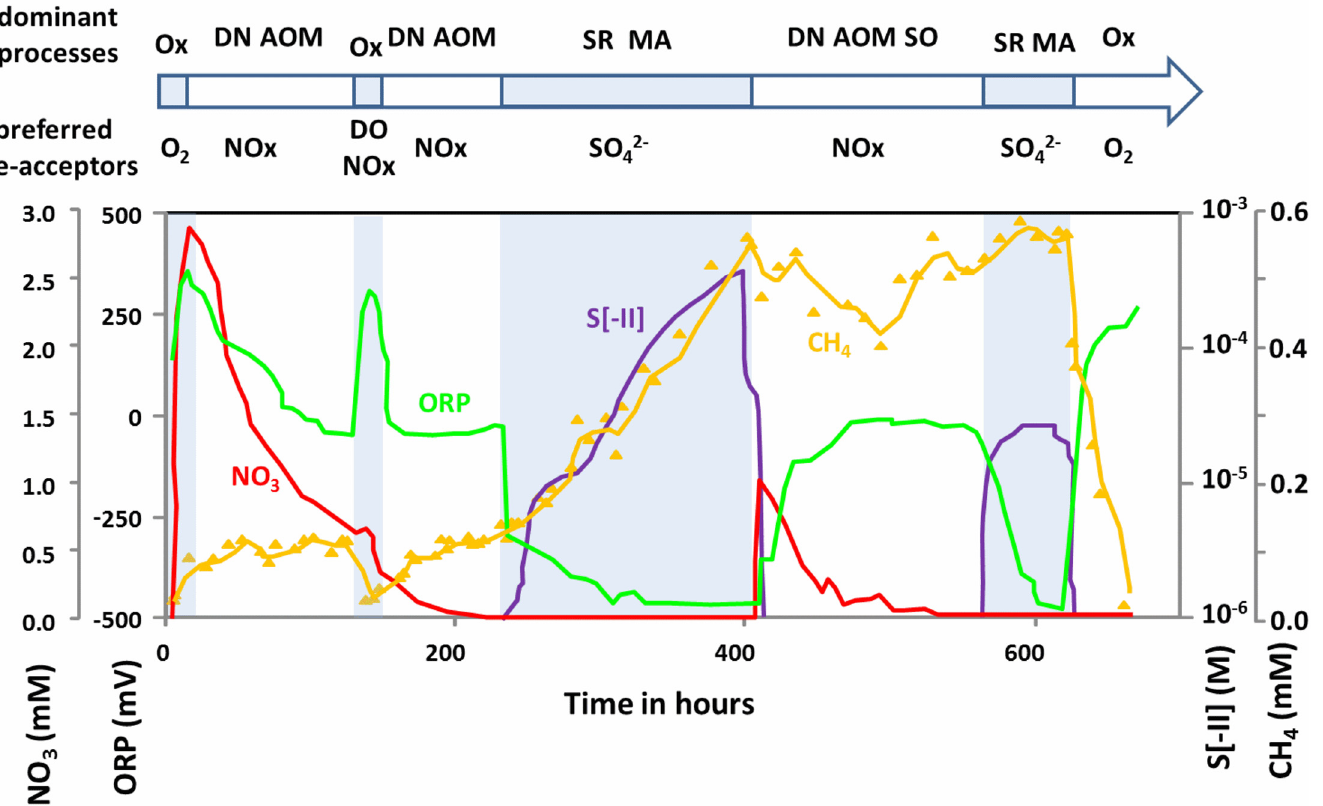
Fig 2. Hydrochemical changes in the overlying water of an incubated sediment core during redox succession. The time line above indicates the different microbial phases within the experiment and highlights the preferred electron acceptors within these phases. Ox: Oxygen consumption; DN: Denitrification; AOM: anaerobic oxidation of methane; MA: Methane Accumulation; SR: Sulfate Reduction; SO: Sulfide